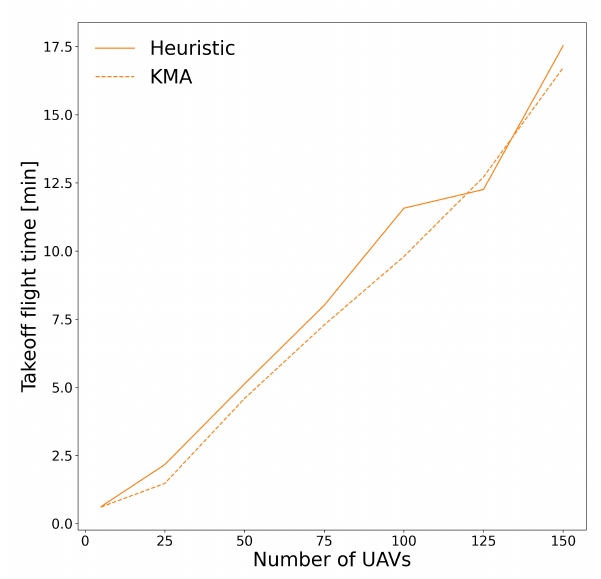
Figure 22. Take-off flight time between heuristic and KMA in the circular formation.